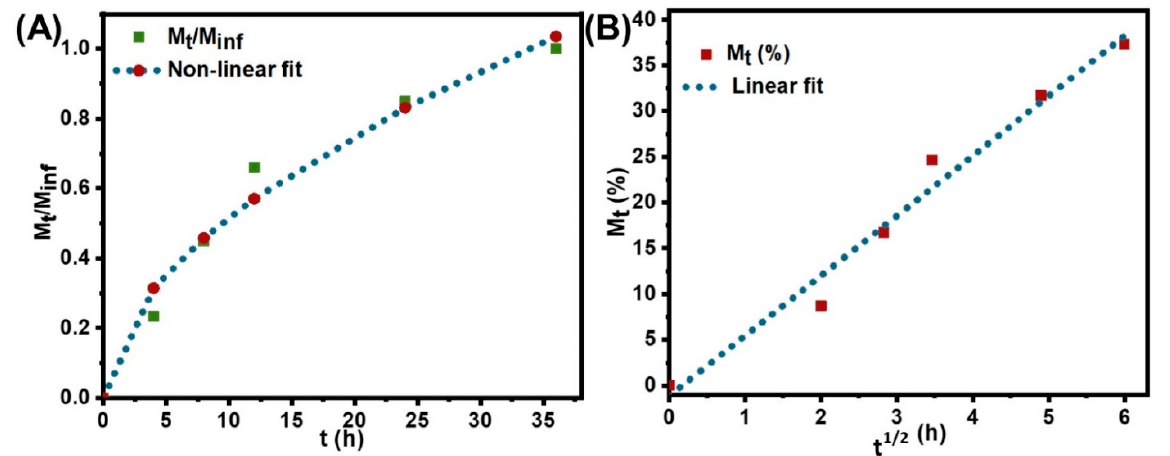
Figure 6. Fitting of cumulative % drug release data to ( A ) Ritger–Peppas and ( B ) Higuchi model for pH 3.